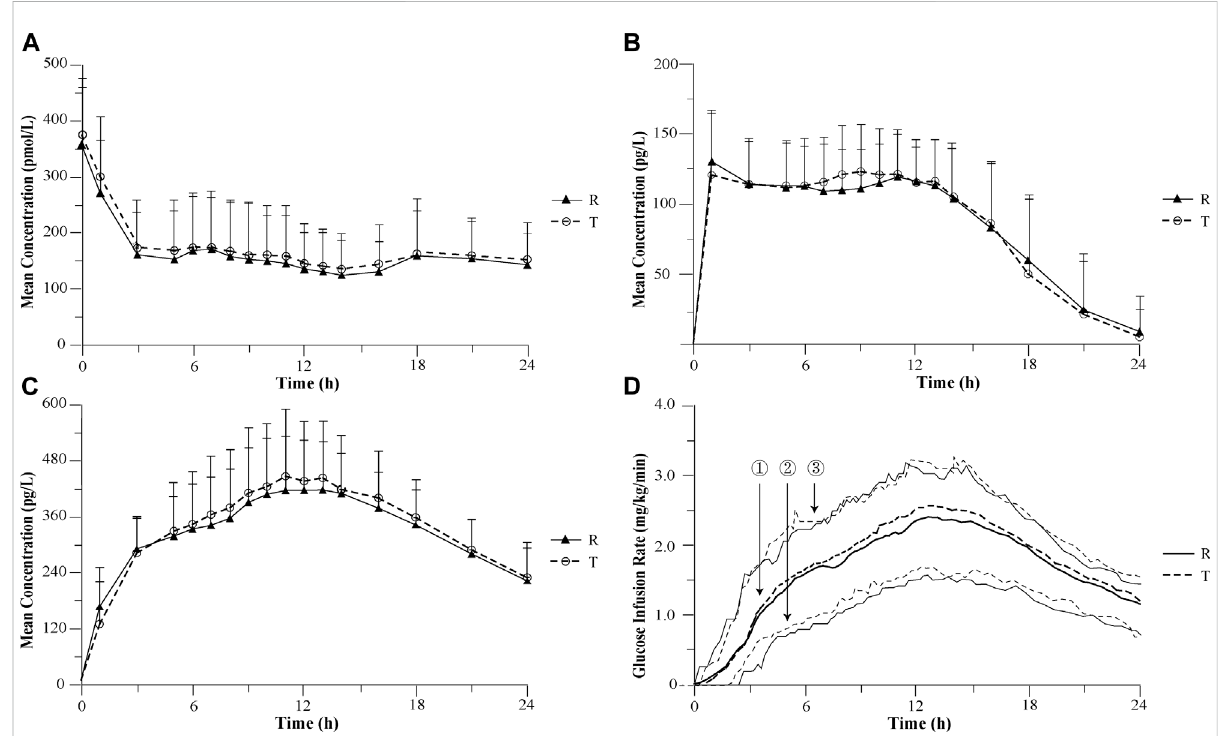
FIGURE 1 Meanpharmacokineticandpharmacodynamicpro fi lesafter0.4 U/kgdosesofrecombinantinsulinglarginedevelopedbyWanbangandLantus in healthy volunteers. (A) Mean C-peptide concentration – time pro fi les after 0.4 U/kg doses of recombinant insulin glargine developed by Wanbang and Lantus in healthy volunteers. (B) Mean parent insulin glargine concentration – time pro fi les after 0.4 U/kg doses of recombinant insulin glargine